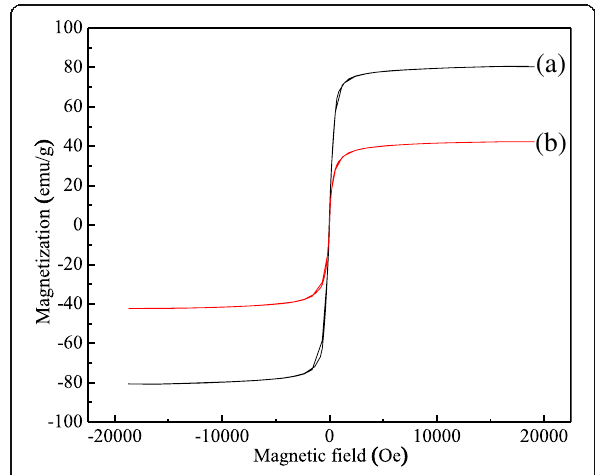
Fig. 4 Magnetic properties of the MCMs. ( a ) The saturation magnetization of the pure Fe 3 O 4 nano/microspheres. ( b ) The saturation magnetization of MCMs